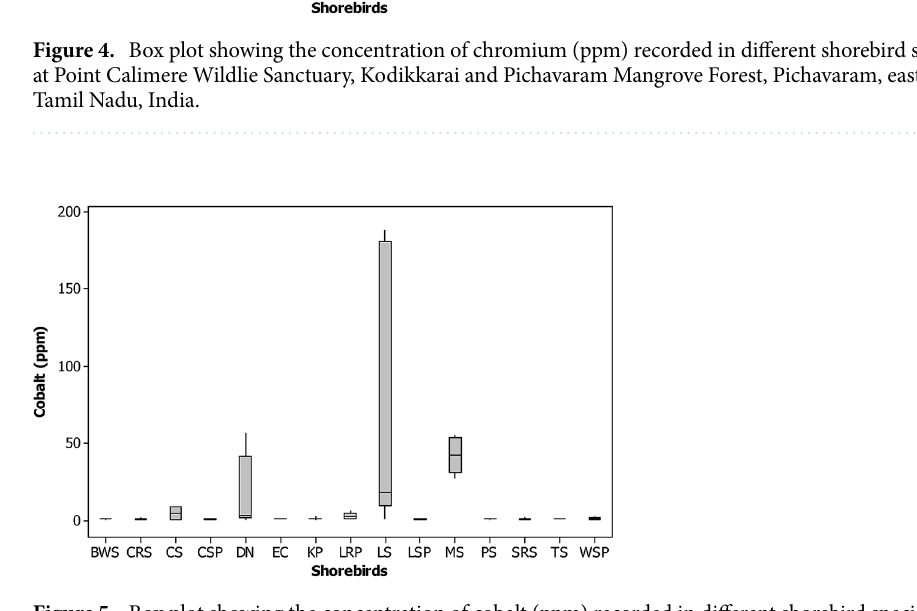
Figure 5. Box plot showing the concentration of cobalt (ppm) recorded in different shorebird species at Point Calimere Wildlie Sanctuary, Kodikkarai and Pichavaram Mangrove Forest, Pichavaram, east coast of Tamil Nadu, India.